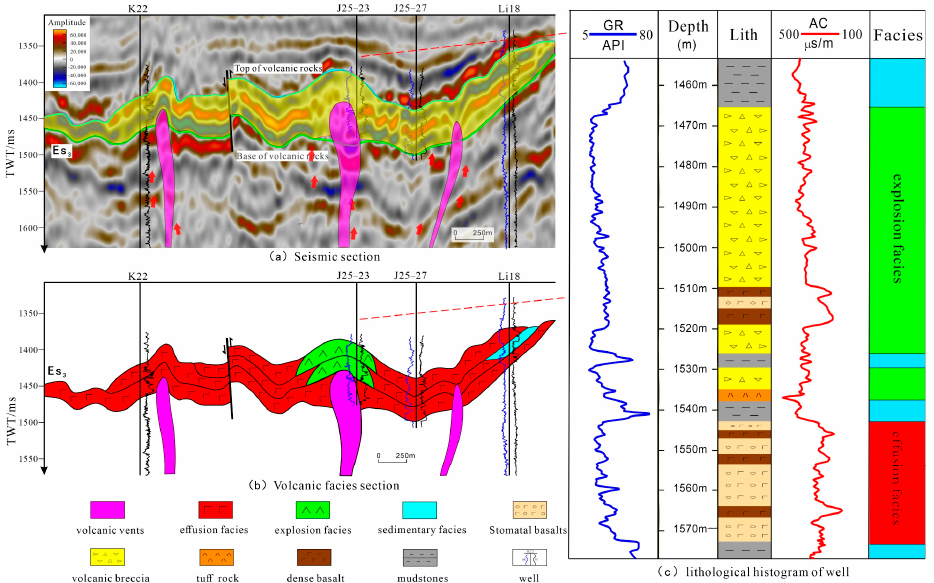
Figure 5. Sectional view of the central volcanic channel in the Zao35 fault block. ( a ) original seismic section; ( b ) volcanic lithofacies section; ( c ) lithological histogram of well. In addition to three central eruptive channels, there are also fissure eruptions with faults as volcanic channels. The volcanic channel width of volcanic fissure type eruption in the Zao35 fault block is small, and the seismic shape is wedge-shaped. Affected by the fault tendency, the volcanic rock mass is developed on the south side of Li Tianmu fault (Figure 6).